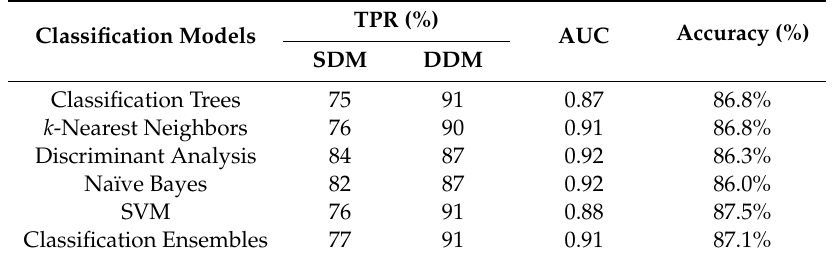
Table 3. TPR, area under the curve (AUC), and accuracy for each classification model.